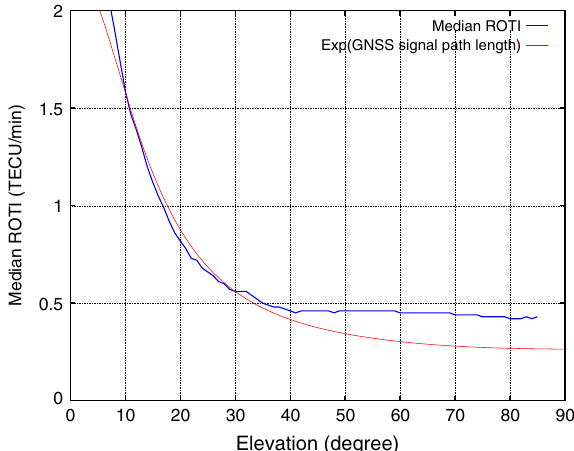
Fig. 6. Dependence of median ROTI (blue line) and the exponential of the GNSS signal path length (red line) on elevation. The red line is scaled to the ROTI level at 30 (cid:2) elevation.